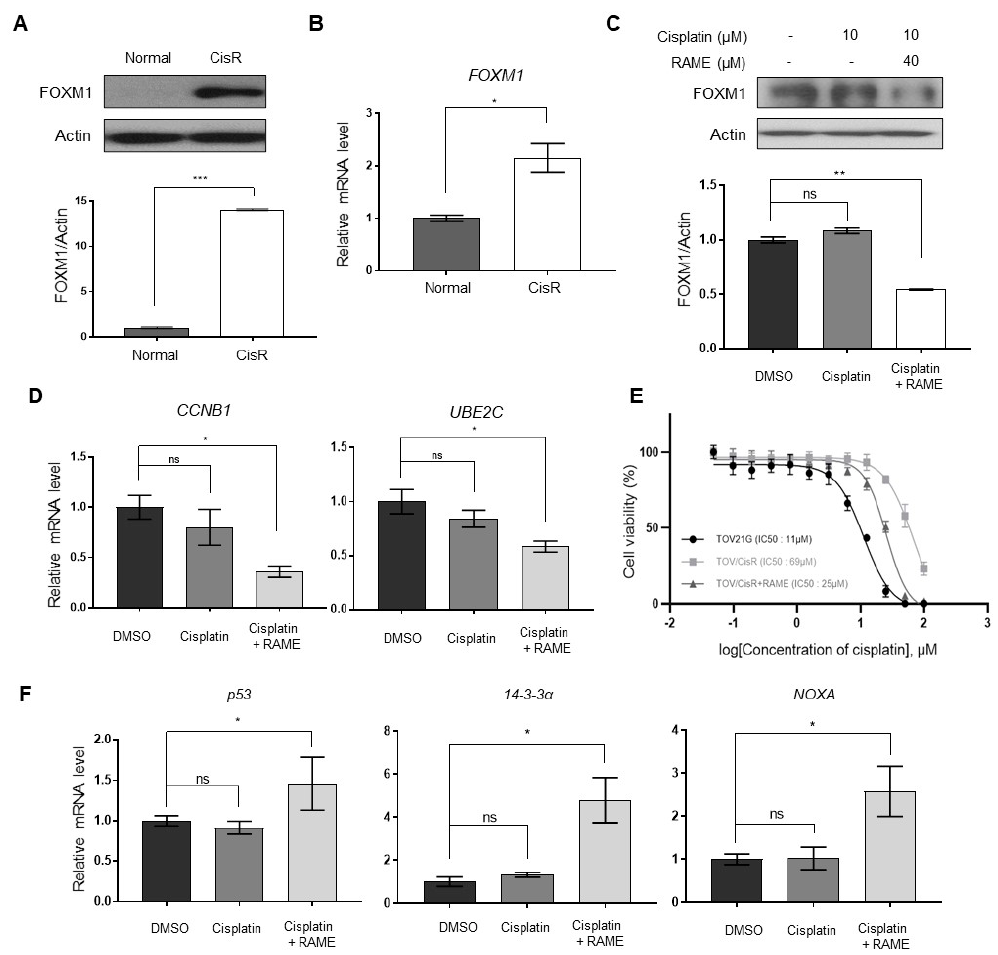
Figure 5. RAME sensitizes cisplatin-resistant ovarian cancer cells. ( A ) Immunoblot analysis of TOV-21G and cisplatin-resistant TOV-21G cells and its quantitative graph. ( B ) The mRNA levels of the Foxm1 gene in TOV-21G and cisplatin-resistant TOV-21G cells. ( C ) Immunoblot analysis of cisplatin-resistant TOV-21G cells and its quantitative graph. ( D ) The mRNA levels of Foxm1-binding genes in cisplatin-resistant TOV-21G cells. ( E ) Cell viability assay curves for cisplatin and the half maximal inhibitory concentration (IC50) values of TOV-21G and cisplatin-resistant TOV-21G cells. ( F ) The mRNA levels of apoptotic genes in cisplatin-resistant TOV-21G cells. Error bars represent the mean ± SEM ( n = 3). * p < 0.05, ** p < 0.01, *** p < 0.001; unpaired t -test.